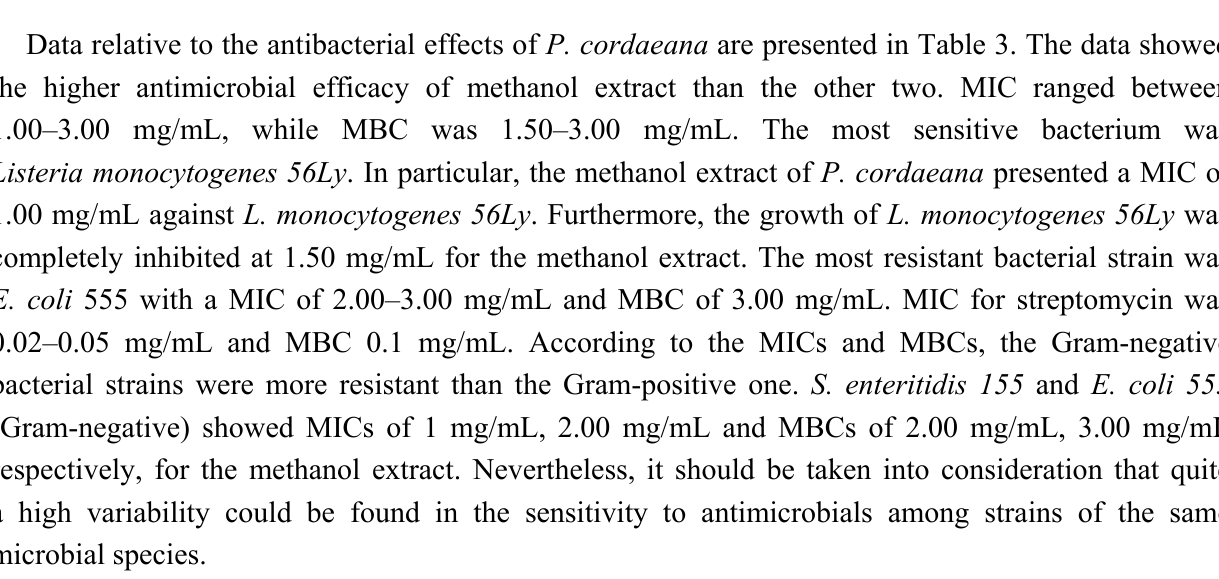
Table 3. Antibacterial activity of P. cordaeana methanol, ethanol and ethyl acetate extracts (mg/mL).